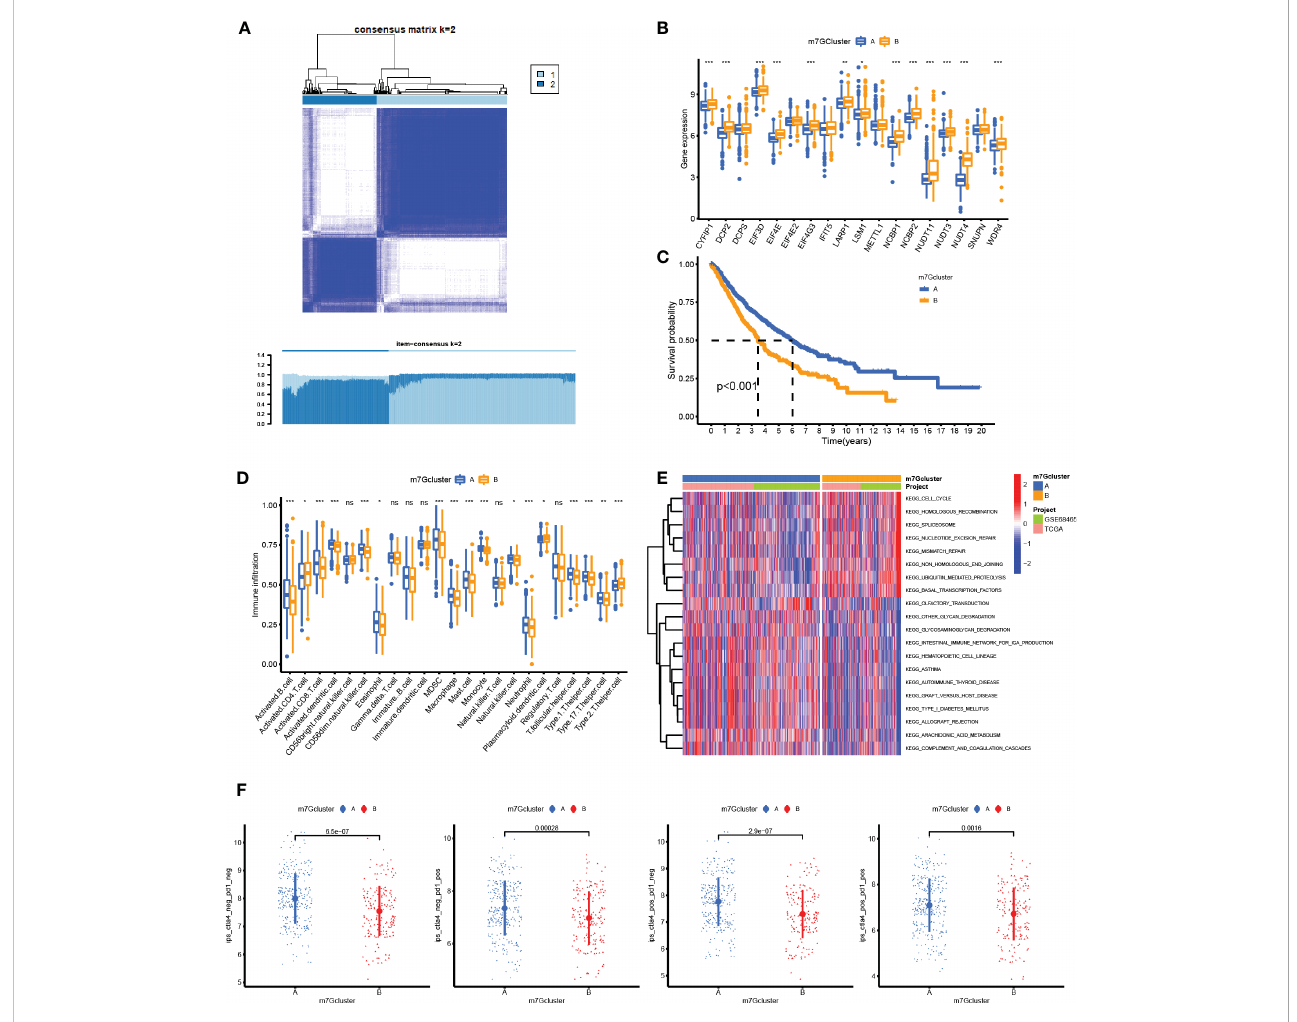
FIGURE 3 Unsupervised consensus clustering analysis. (A) Heatmap showed that the samples were distinctly divided into two clusters. (B) Boxplot of N7- methylguanosine (m7G)-related gene mRNA expression between the two clusters. (C) Survival plot for the two clusters. (D) In fi ltration level of immune cells in different clusters. (E) Heatmap for KEGG pathway enrichment in the two clusters. (F) Immunophenoscore for predicting the responsiveness to CTLA-4 checkpoint inhibitors and PD-1 checkpoint inhibitors. CTLA-4: Cytotoxic T-lymphocyte associated protein 4; PD-1: Programmed cell death 1. (*P <0.05, **P < 0.01, ***P < 0.001, ns: Not statistically signi fi